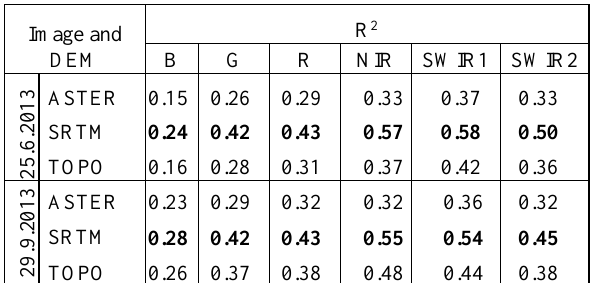
Table 3. Summary of the linear regression results between different predictor variables and Fcover, and two images. The predictors with subscripts were topographically corrected using either ASTER, SRTM and TOPO DEM. Values in bold are the highest R 2 and lowest RMSE. All the models were statistically highly significant (p < 0.0001).